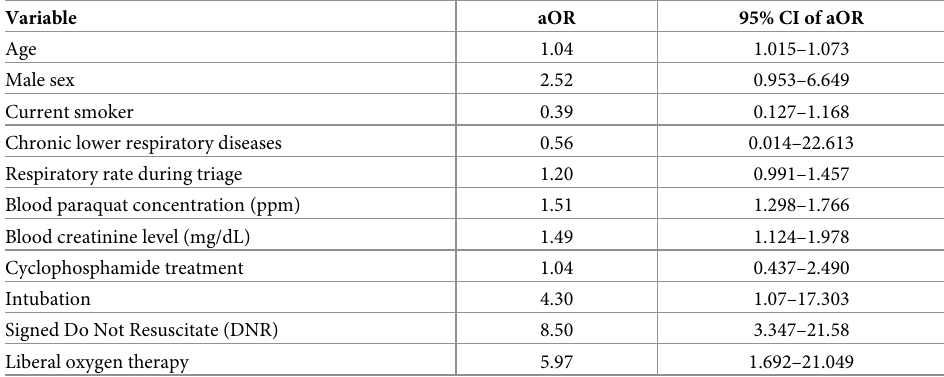
Table 3. Logistic regression analysis of risk factors associated with overall